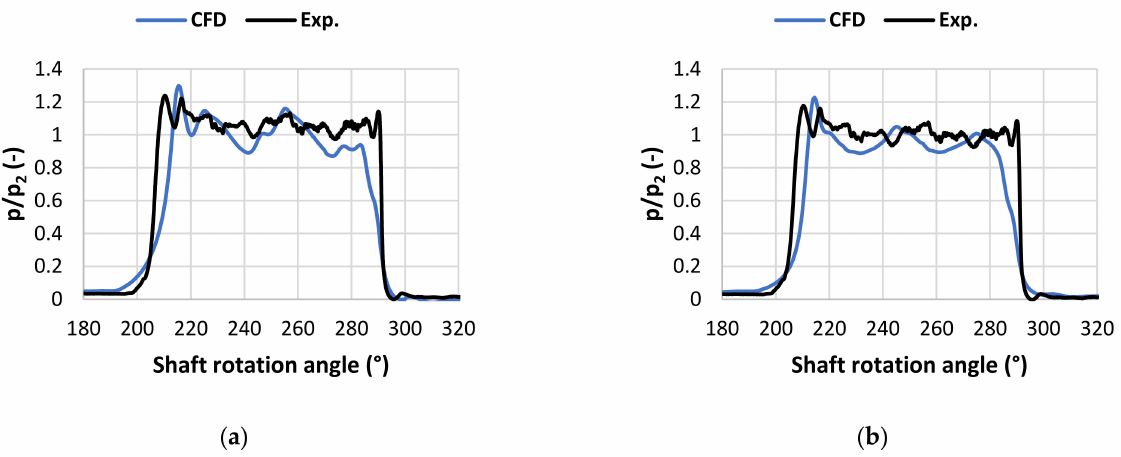
Figure 28. Displacement chamber pressure profiles for the BVP at 20 ◦ C oil temperature, 2000 rpm, IGVF = 5% for ( a ) p 2 = 5 bar and ( b ) p 2 = 10 bar pressure